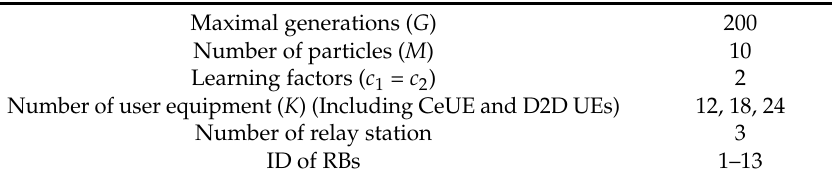
Table 2. Simulation parameters of